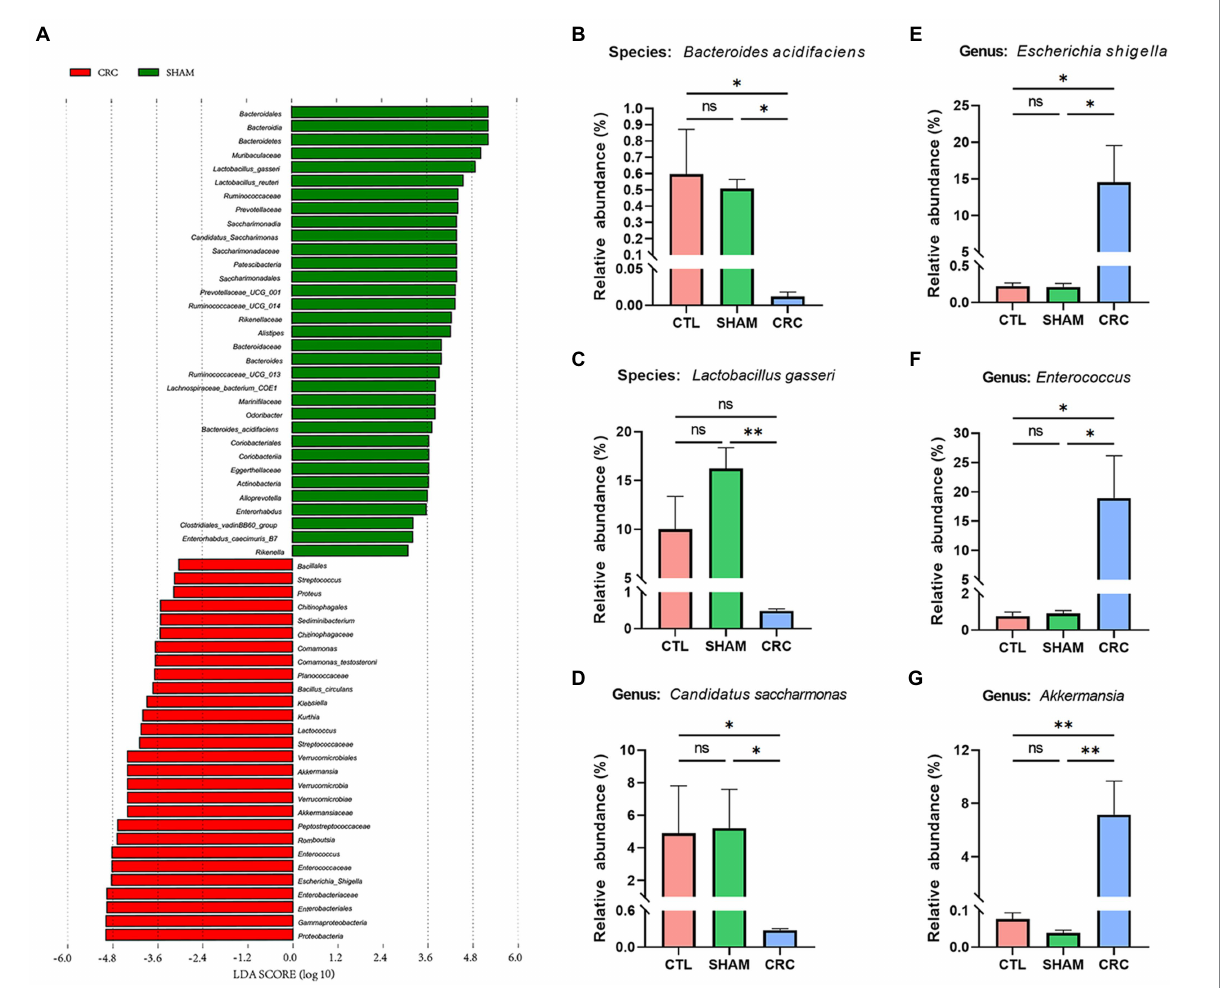
FIGURE 3 Identification of signature bacteria in CRC and excess colonization of Akkermansia muciniphila . (A) Linear discriminant analysis effect size (LEfSe) analysis between the CRC and SHAM groups with the highest linear discriminant analysis (LDA) score [log (LDA score) ≥ 3]. Relative abundances of Bacteroides acidifaciens (B) , Lactobacillus gasseri (C) , Candidatus saccharimonas (D) , Escherichia Shigella (E) , Enterococcus (F) , and Akkermansia (G) . Data are mean ± SEM; n ≥ 3, “ns,” not significant, * p < 0.05, and ** p <